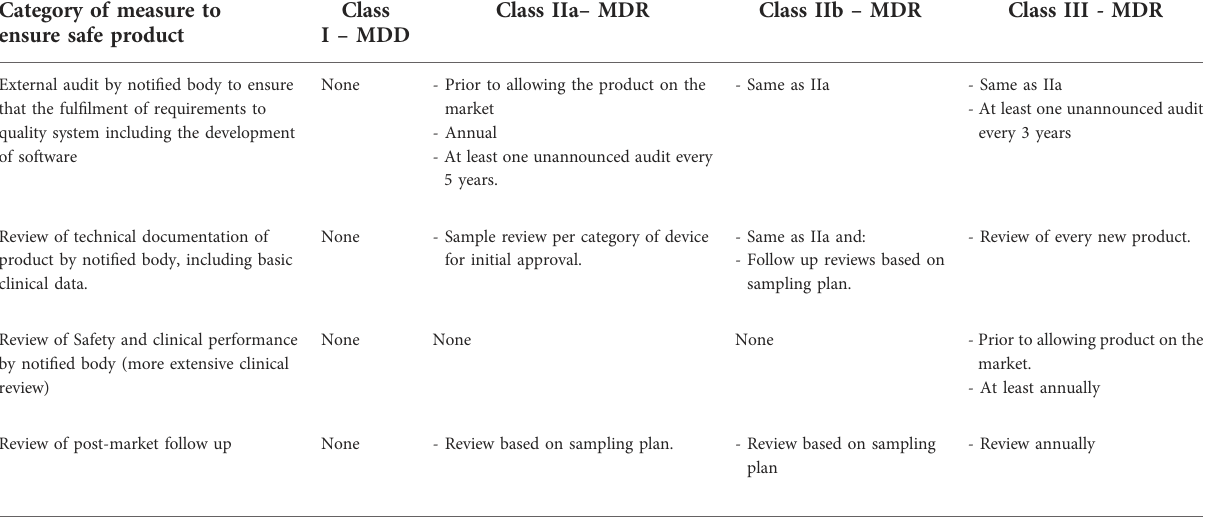
TABLE 2 Comparing measures to ensure safe use of the products on the market. Category of measure to ensure safe